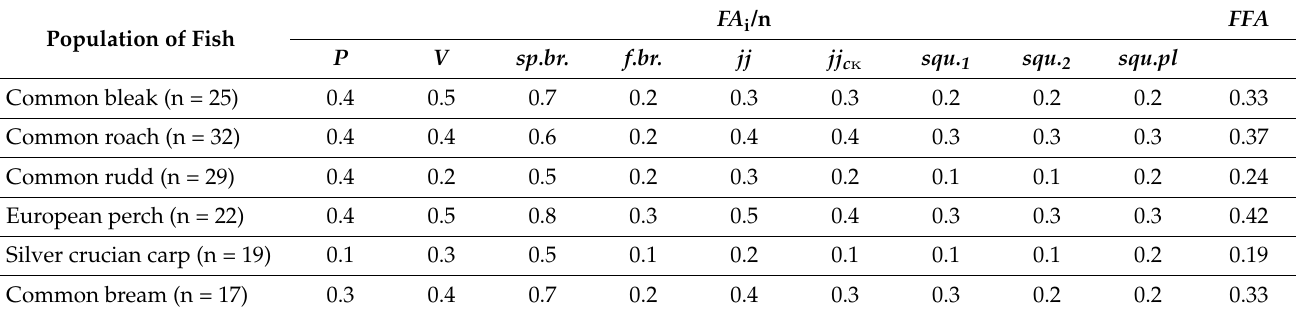
Table 10. The FFA for each studied fish population in the River Styr at sampling site No. 8 ( p ≤ 0.05). Population of